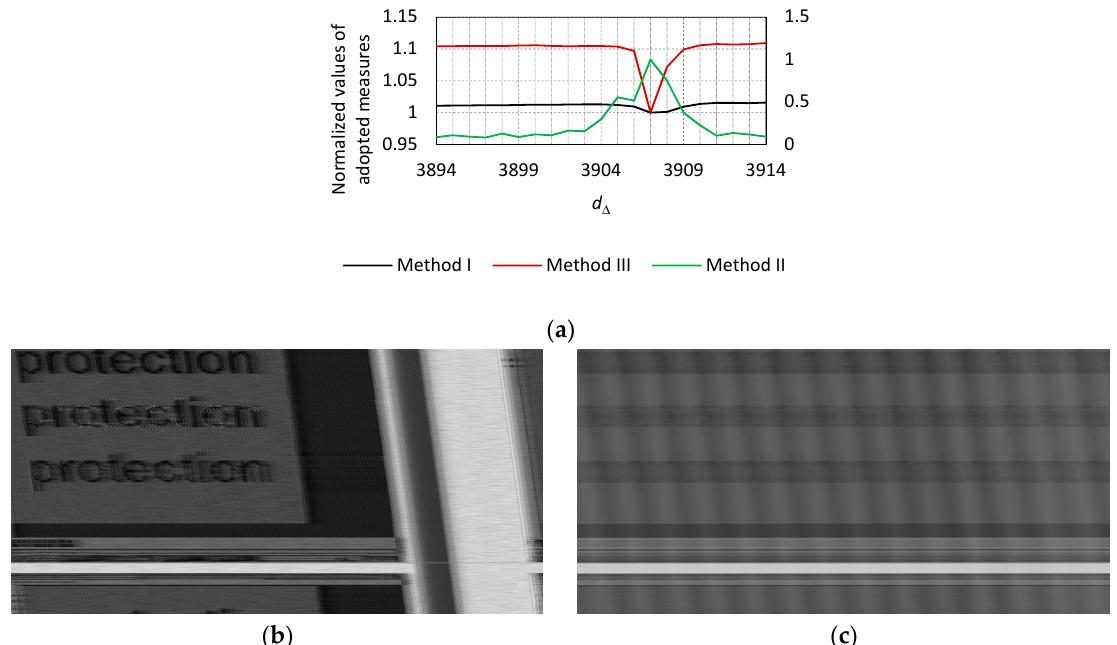
Figure 21. ( a ) The normalized values of the adopted measures (method I, II and III) calculated in domain of image line length d ∆ for the accuracy ∆ = 1.0 (for the original image shown in Figure 7c) and images reconstructed on the basis of the recorded revealing emission signals at frequency f o = 768 MHz (receiving bandwidth BW = 50 MHz, accuracy ∆ = 1.0), ( b ) for estimated line length d ∆ = 3907.00000, image summation multiple Sum MTL = 1 and ( c ) for estimated line length d ∆ = 3907.00000, multiple of image summation Sum MTL = 60 —the source of revealing signal emission—display monitor, HDMI